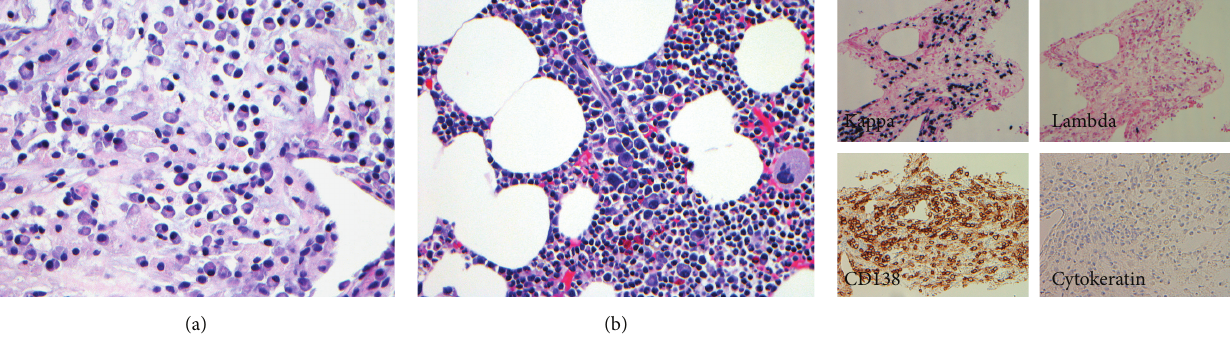
Figure 2: Photomicrographs from femur bone biopsy (a) and bone marrow clot preparation (b) showing a monomorphic population of plasma cells intermixed with few small lymphocytes and other hematopoietic cells in the bone marrow. The plasma cells show mature cytological features with strong CD138 reactivity and restriction for kappa light chain. No morphologic evidence of carcinoma is identified in both specimens and staining with cytokeratin marker is negative. [(a) H&E, × 100; (b) H&E, ×